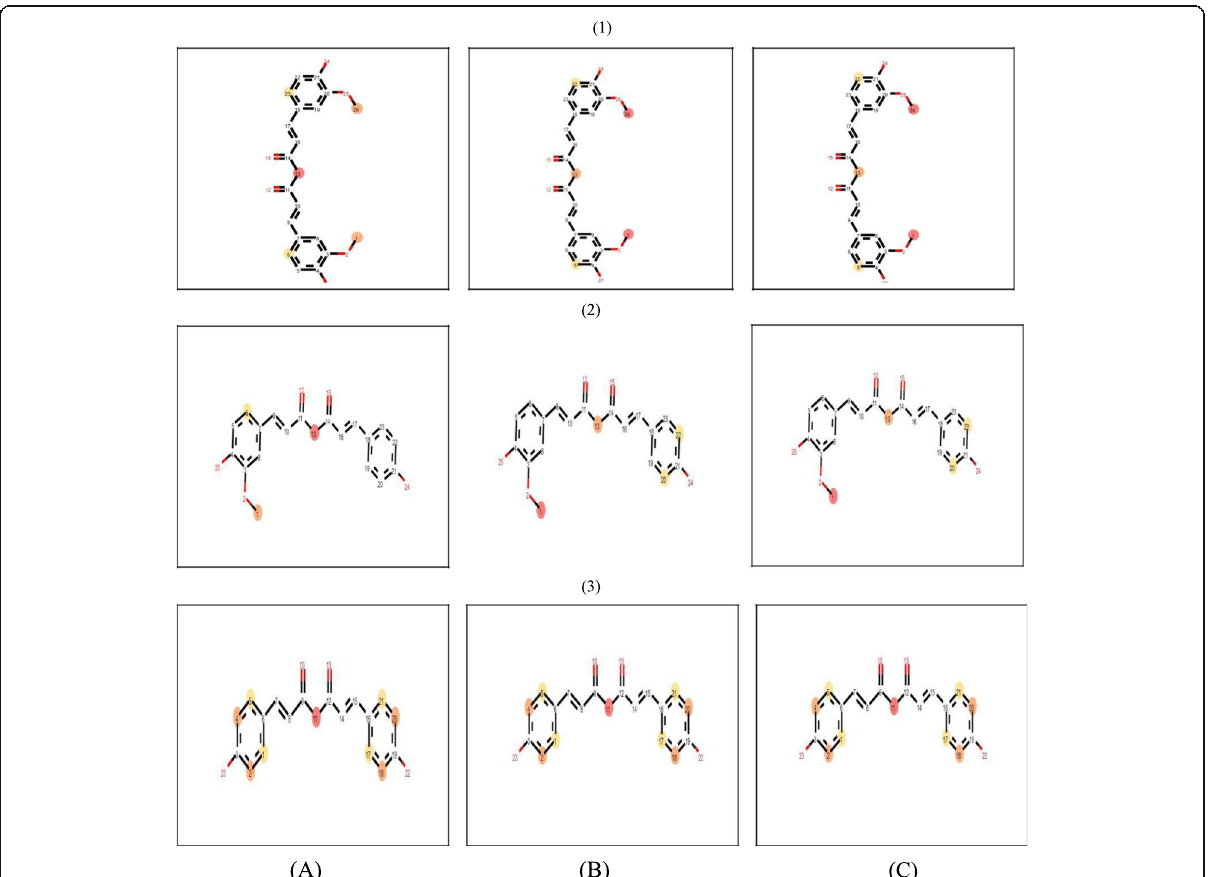
Fig. 7 Representation of best possible atoms (marked in colored spheres) of (1) curcumin I (PubChem CID: 969516), (2) curcumin II (PubChem CID: 5469424), and (3) curcumin III (PubChem CID: 5315472) subjected to metabolism by the CYP450 group of enzymes ( A ) CYP 3A4, ( B ) CYP 2D6, and ( C ) CYP 2C9. Atoms marked in a darker sphere are subjected to have better probability of metabolism by enzymes followed by the ones marked in a lighter